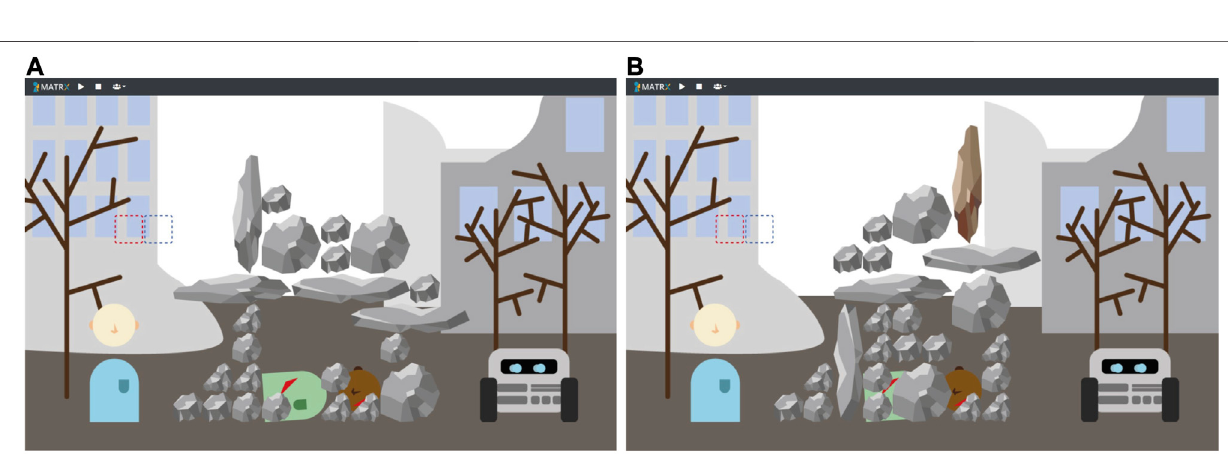
Frontiers in Robotics and AI |